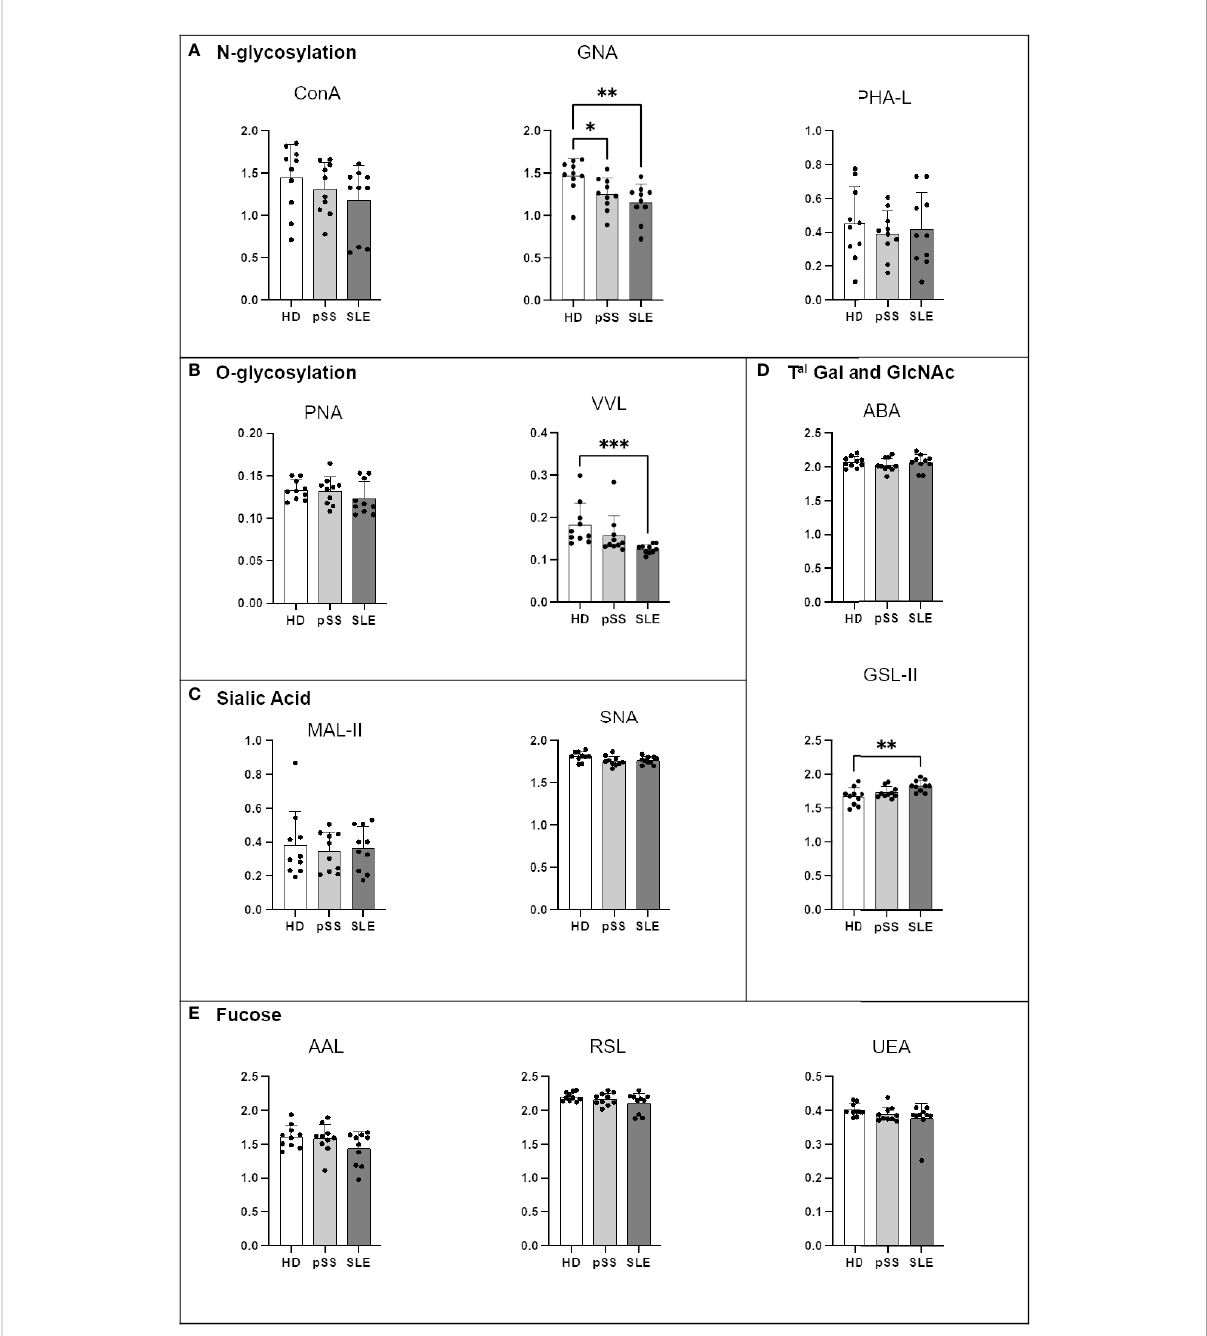
FIGURE 7 Comparison of IgA1 N- and O-glycosylation from systemic lupus erythematosus (SLE), primary Sjögren ’ s syndrome (pSS) and healthy donors (HD). Mouse anti-Human IgA1 (RM124 clone) was coated at 0.5 µg/mL in MaxiSorp 96-well plates overnight at 4°C. A PBS solution containing 2% of Bovine Serum Albumin (BSA) or Carbohydrate-Free Blocking Solution were used for saturation depending on the lectins. This information is described in Table 4. After saturation, an oxidation was performed, to cleave terminal glycans present on anti-Ig and saturating buffer, with a solution of sodium periodate at the fi nal concentration of 0,0 5M in 0,05 M pH=4 citrate buffer. Serum from healthy donors (HD), primary Sjögren ’ s syndrome (pSS) and SLE diluted to 1/100e were added for 1 h at 37°C. After 5 wash steps with PBS 0,05% Tween20, the biotinylated lectins described in Table 2 were added for 1 h. Plate was washed 5 times and streptavidin-Horse Radish Peroxydase (HRP) was added for 30 min at for 2 h at room temperature (RT). After 5 wash steps, a colored reaction using tetramethylbenzidine was performed and stopped with sulfuric acid. The optical density (OD) at 450 nm was determined. Results are presented as followed: N-glycosylation in (A) , O-glycosylation in (B) , Sialylation in (C) , Terminal (T al ) Gal and GlcNAc on N and O-glycosylation in (D) , Fucosylation in (E) . One-way anova test followed by Dunn ’ s multiple comparison test were performed. ns, not signi fi cant p > 0,05, stars are indicated when p< 0,05 (*) < 0,01 (**); < 0,001